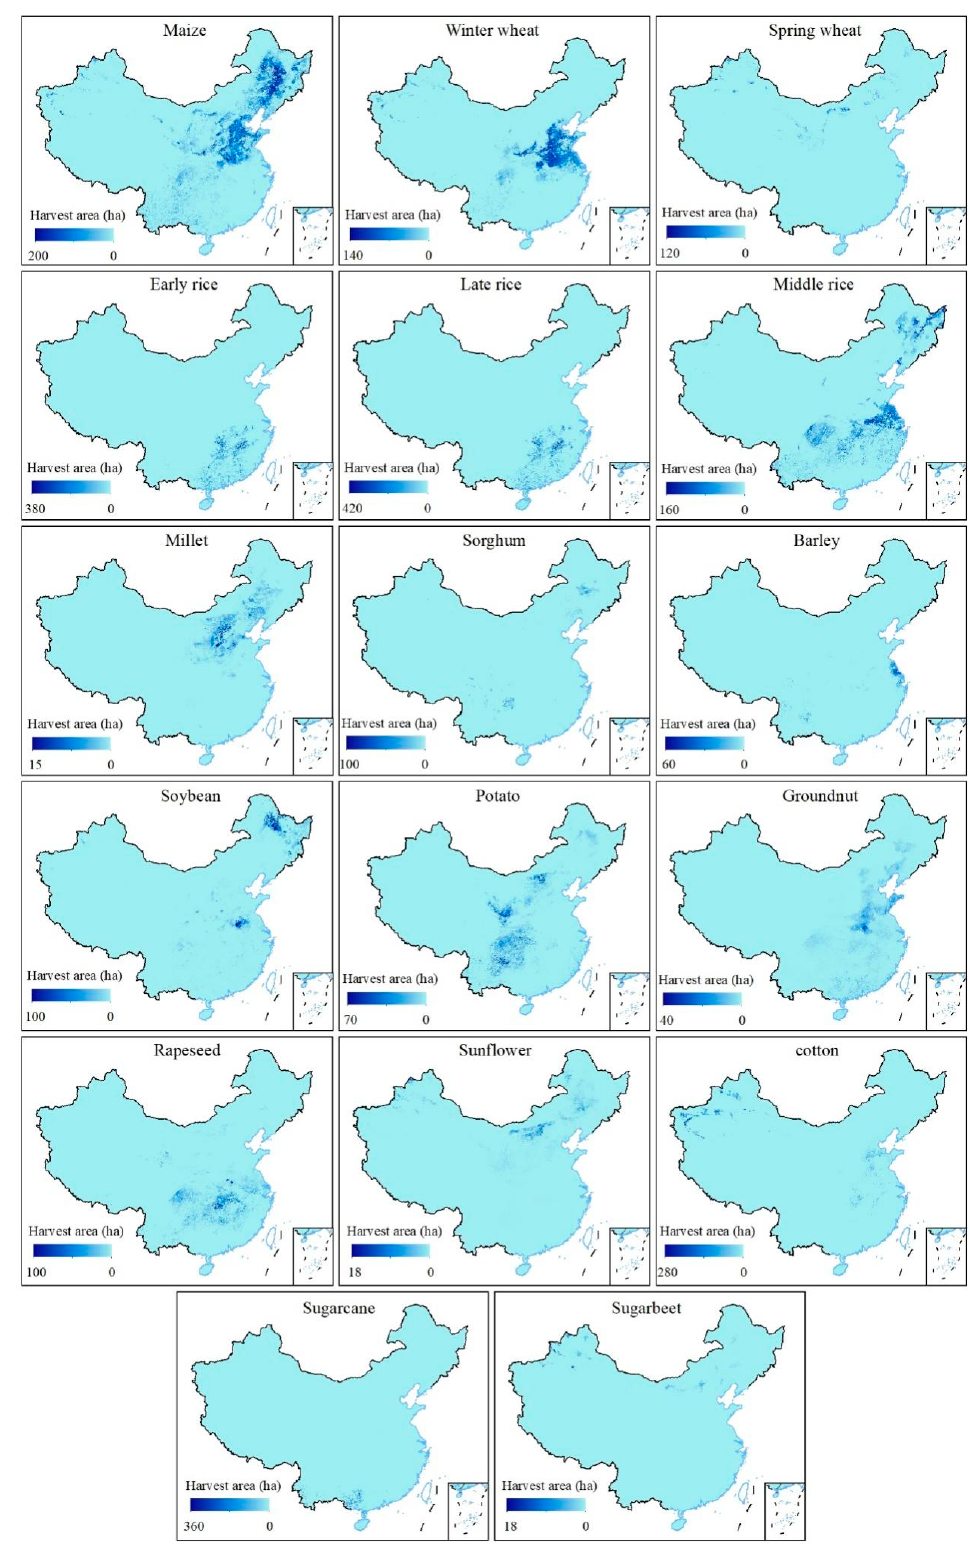
Figure 8. Spatial distribution of the 14 studied crops (including three varieties for rice and two for wheat) in 2015.